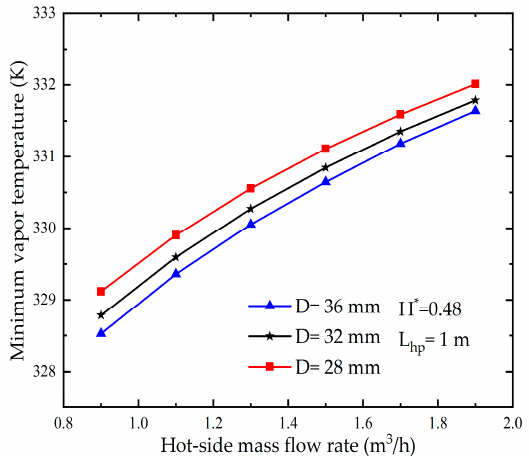
Figure 10. Comparison of the minimum vapor temperature with different HP diameters. (The mass flow rate at cold side of the HPHEX is 2.9 m 3 /h.)